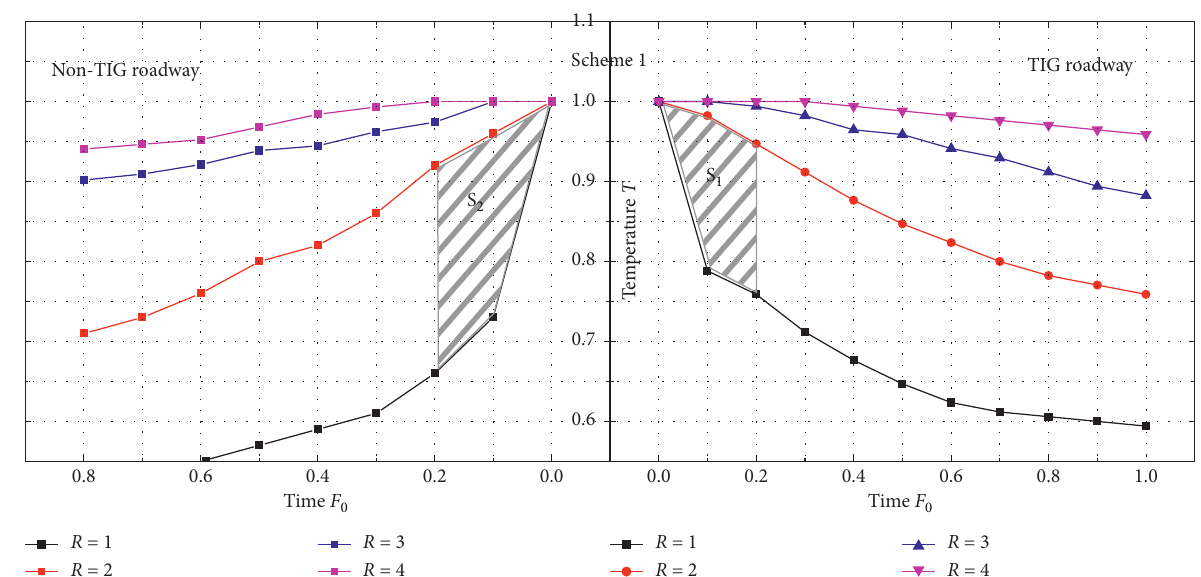
Figure 5: T − F curves of the TIG roadway and non-TIG roadway. 0